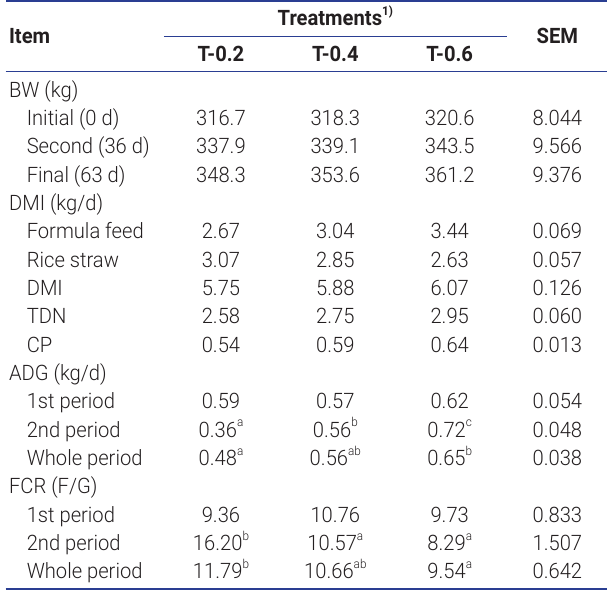
Table 3. Effects of dietary energy and protein levels on performance of Hanwoo